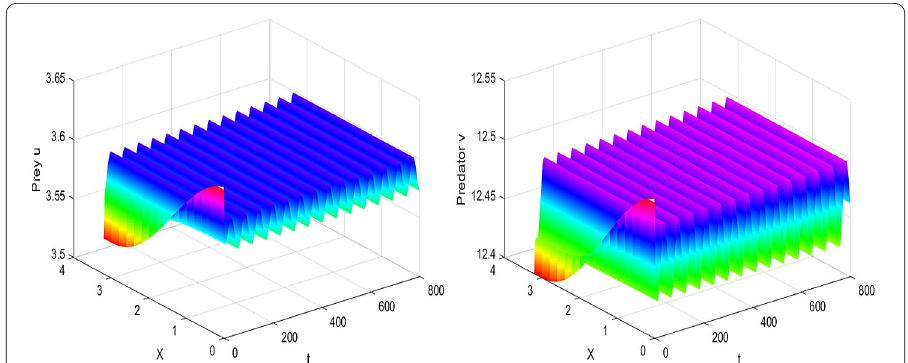
Figure 4 The periodic solutions bifurcating from the coexisting equilibrium E ∗ where τ = 4.2 > τ 0 .